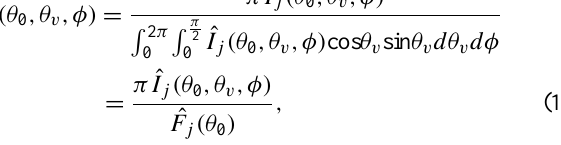
Figure 1. Diagram showing zenith and azimuth angles used in this study. θ 0 and φ 0 (orange section) indicate the solar zenith angle and azimuth angle (defined from north), respectively. θ v is the viewing zenith angle of the CERES instrument. φ (grey section) is the rel- ative azimuth angle between the CERES azimuth and the solar az- imuth. The blue line indicates the direction of sastrugi, and the blue section shows sastrugi azimuth angle, φ sastrugi . φ sas is the relative azimuth between the sastrugi azimuth and the solar azimuth and is illustrated by the green